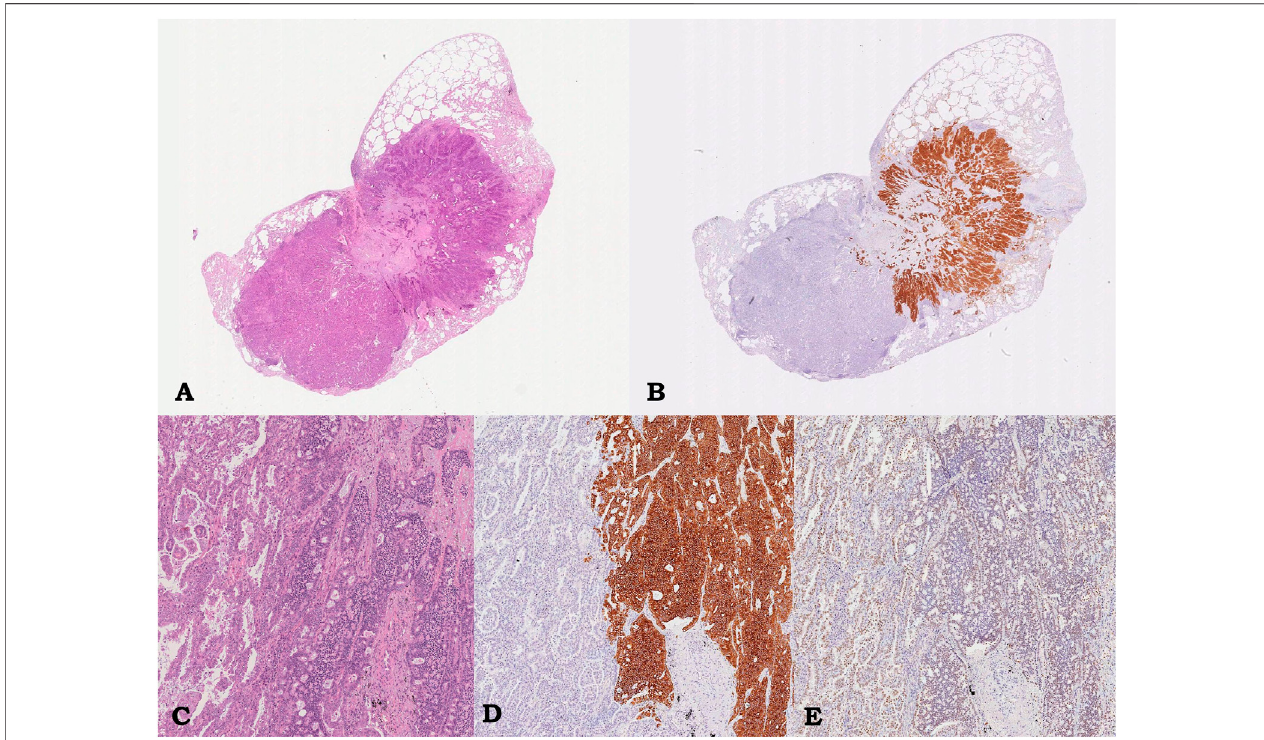
FIGURE 1 | Case 1, pulmonary lesion. Intraparenchymal neoplasm consisting of glandular component corresponding to lepidic-papillary pulmonary adenocarcinoma, on the left, and of adhered trabecular proliferation of monomorphic epithelioid cells corresponding to atypical carcinoid, on the right; hematoxylin/ eosin, 0.5x (A) and 5.5x (C) . Immunostaining showing diffuse and strong immunoreactivity for Synaptophysin only in the carcinoid component ( on the right, 5.5x; B, D) and immunoreactivity for TTF-1 in both component ( 5.5x, D) .